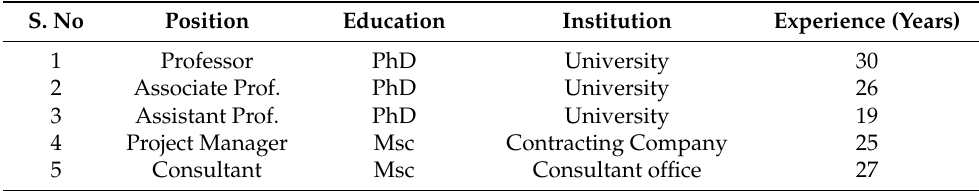
Table A1. Details of Institutional Review